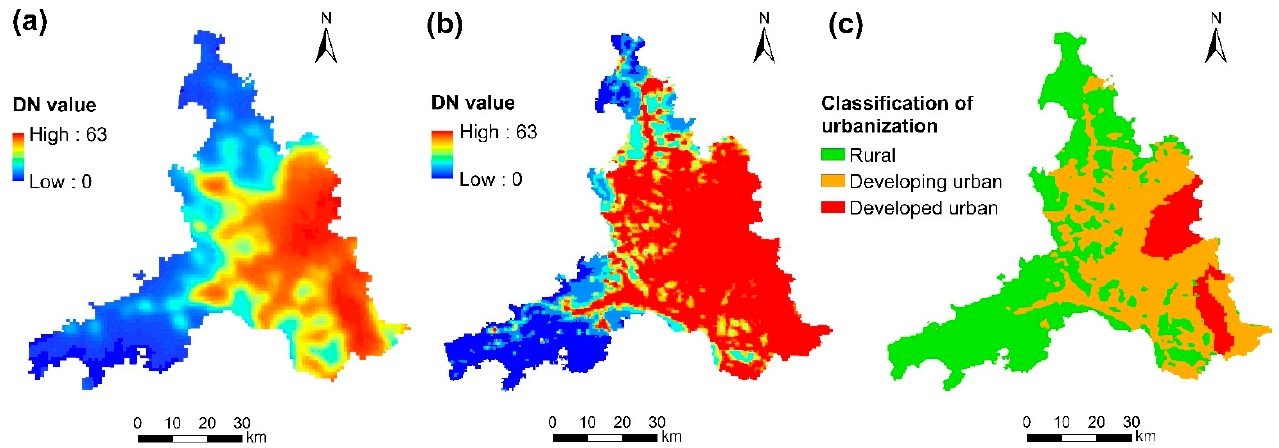
Figure 5. Classification of urbanization level based on digital numbers (DN) in Foshan from 2000 to 2018: ( a ) DN value in 2000, ( b ) calibrated DN value in 2018, and ( c ) classification of urbanization in Foshan.